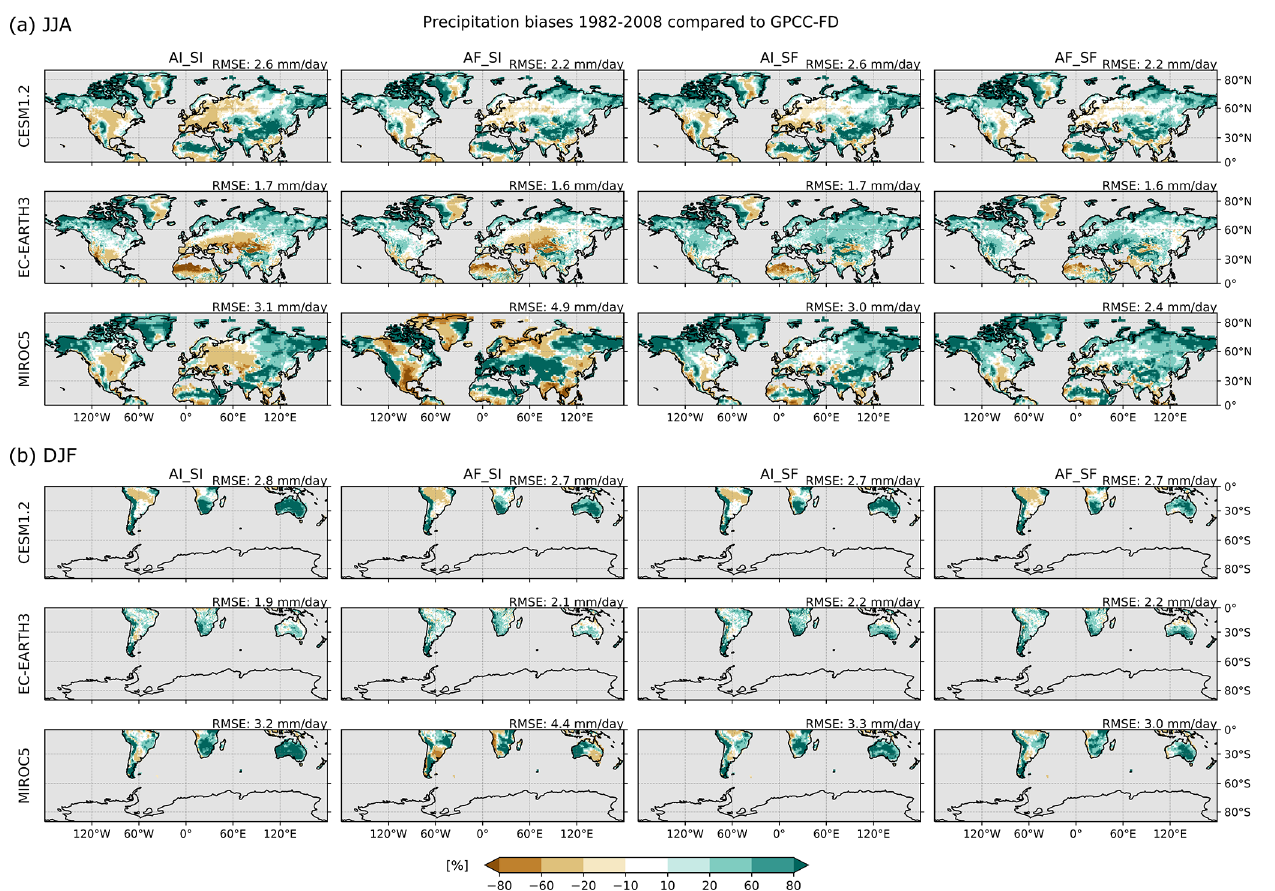
Figure 5. Bias in total precipitation with respect to GPCC-FD. Shown is the seasonal average over (a) JJA for the Northern Hemisphere and (b) DJF for the Southern Hemisphere. Values are plotted as the percentage deviation from the reference data set. Ocean grid points, Antarctica, and grid points with a seasonal average of less than 0.1mm precipitation per day in the reference data set are masked out in grey. The RMSE averaged over all valid grid points of the respective hemisphere is given in millimeters per day in the upper right corner of each experiment and